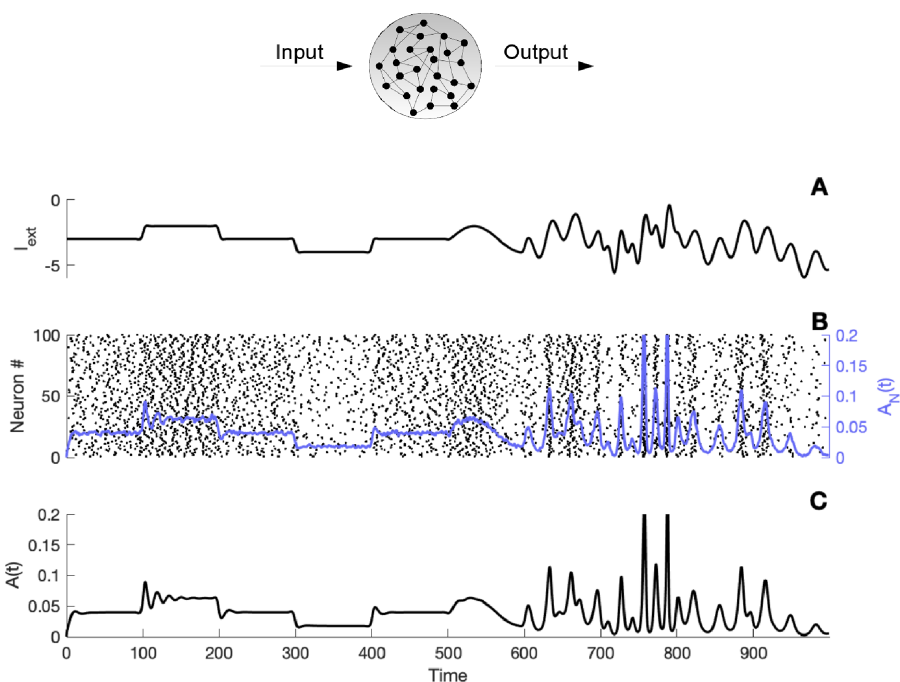
Fig 1. Dynamics for a recurrent excitatory network. Comparison of firing activity. A) Time evolution of the stimulus I ext ( t ). B) Raster plot of 100 neurons, the blue line displays the resulting firing activity Eq (1) of the full network. C) Firing activity obtained from a simulation of the mean-field Eq (3). The simulation was initiated with a similar Gaussian profile for the full network and the mean-field equation, parameters: S ( h , r ) = exp( h ) H ( r − T − T ref ) / τ )), T ref = 10 ms , τ s = 10 ms , τ = 5 ms , J s = 15 mV . ms , N = 5000 and Δ t = 0.05 ms